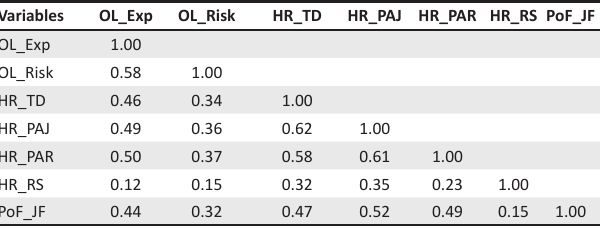
TABLE 3: Correlation analysis ( n = 609).